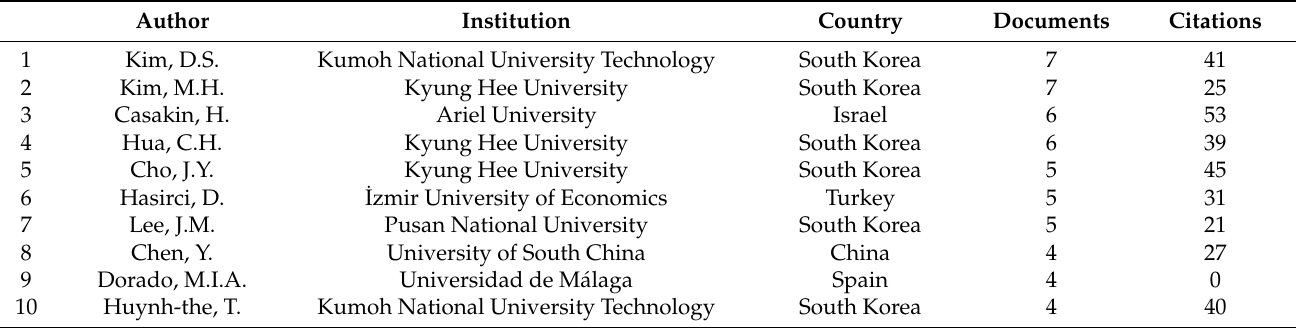
Table 3. Most productive authors, organizations, and countries in the WoS